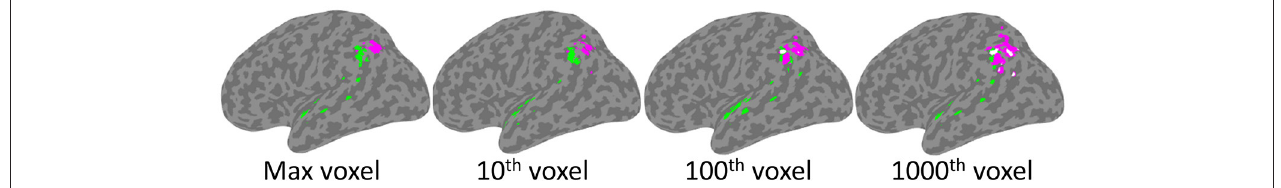
FIGURE 4 | SVR-LSM results for Phonological Working Memory (magenta) and Orthographic Working Memory (green). Clusters projected onto a left hemisphere standard MNI152 cortical surface using mni2fs (56). Each image depicts the results using thresholds which, from left to right, are based on increasingly more lenient thresholds from the permutation analysis. Although there is some overlap (white) at the two most lenient thresholds, there is none at the more conservative max and 10th voxel thresholds.